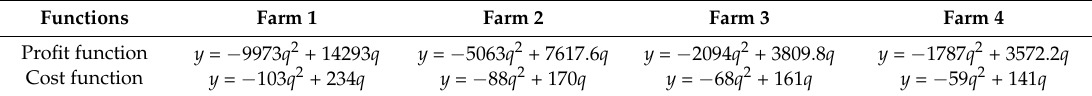
Table 2. Profit function and cost function with respect to share of irrigated area ( q i ).